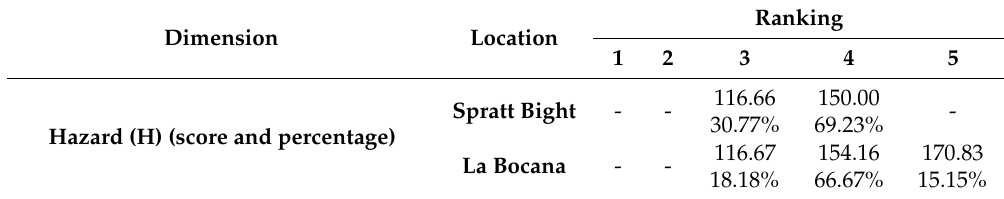
Table 7. Coastal erosion hazard results, by study area, ranking, final score obtained, and percentage. The percentage represents the number of segments on each ranking over the total number of